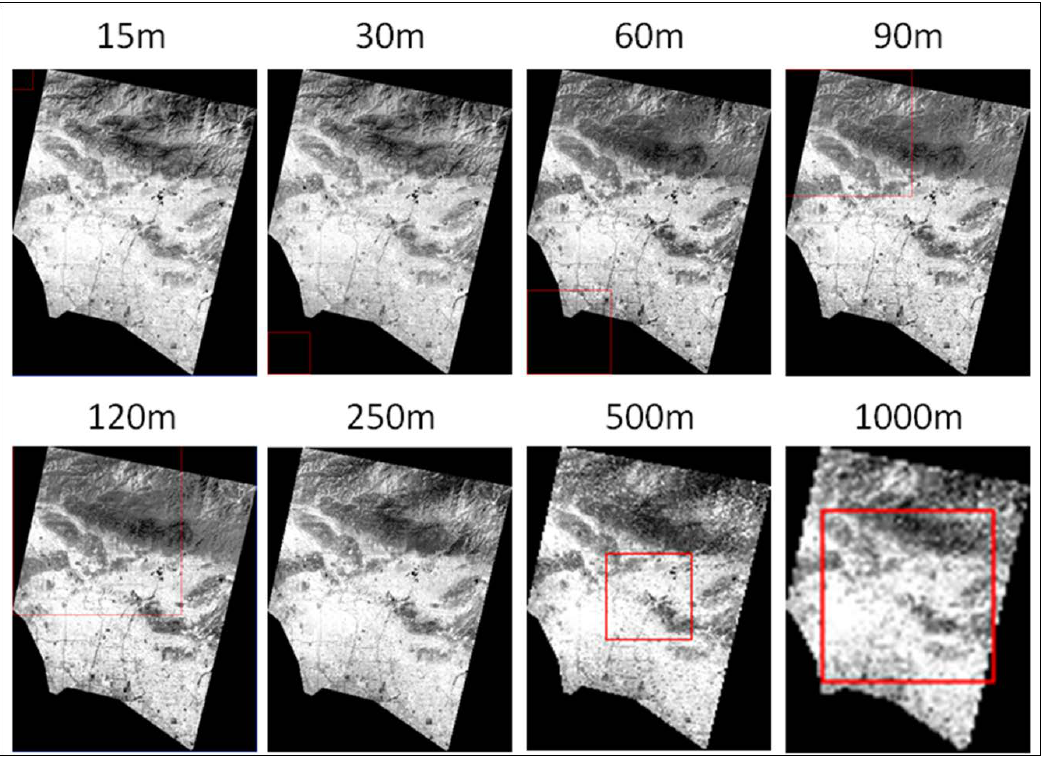
Figure 5. Simulated LST images across the scales.